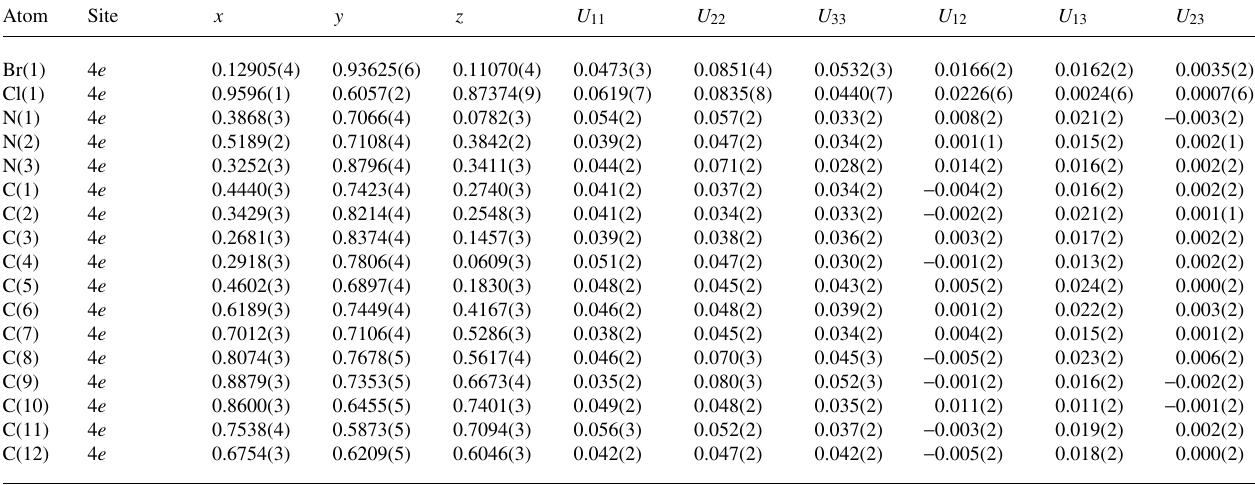
Table 3. Atomic coordinates and displacement parameters (in Å 2 ) .